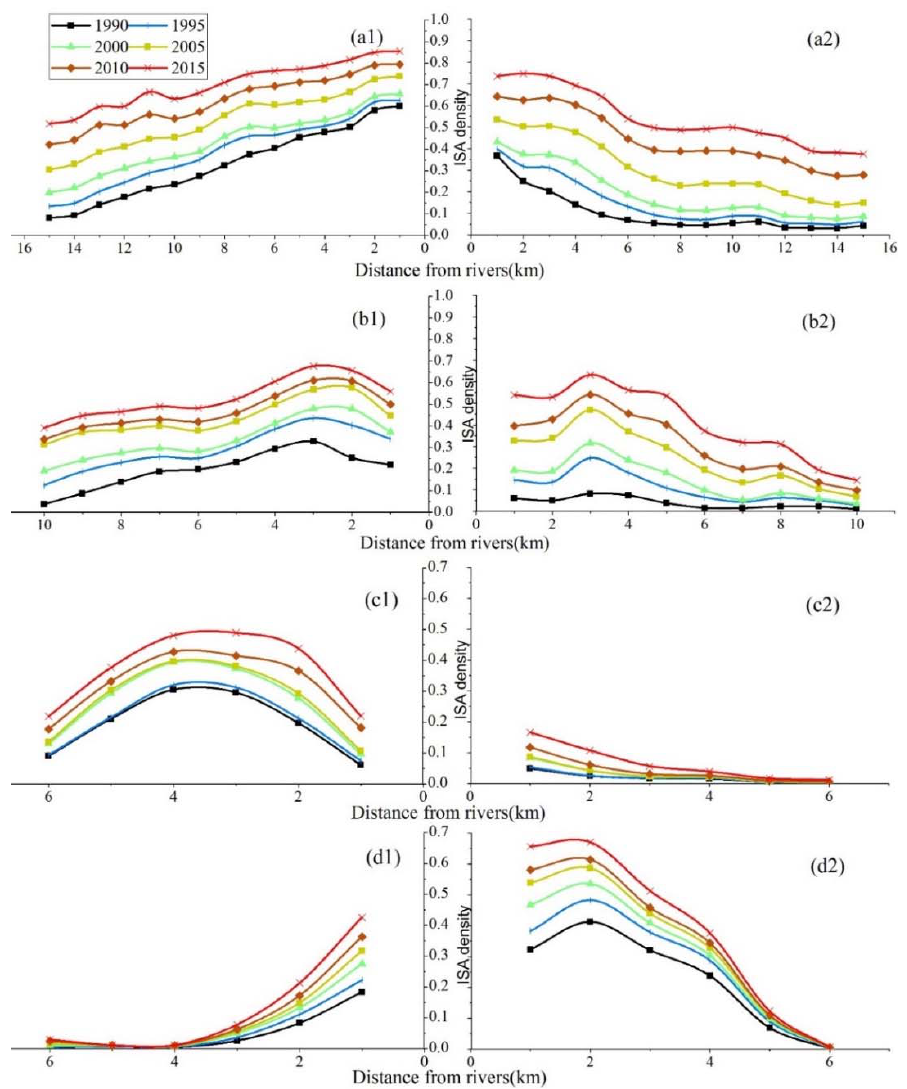
Figure 11. The ISA density expansions in the buffer zones away from the rivers; ( a1 , a2 ) represent the west and east sides, respectively, of Huangpu River, Shanghai; ( b1 , b2 ) represent the west and east sides, respectively, of Saigon River, Ho Chi Minh City; ( c1 , c2 ) represent the north and south sides, respectively, of Tuul River, Ulaanbaatar; and ( d1 , d2 ) represent the north and south sides, respectively, of Yellow River, Lanzhou.